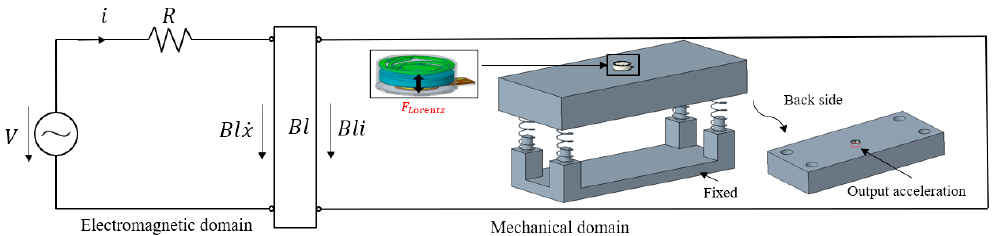
Figure 8. Diagram of the electromagnetic-mechanical coupling method.